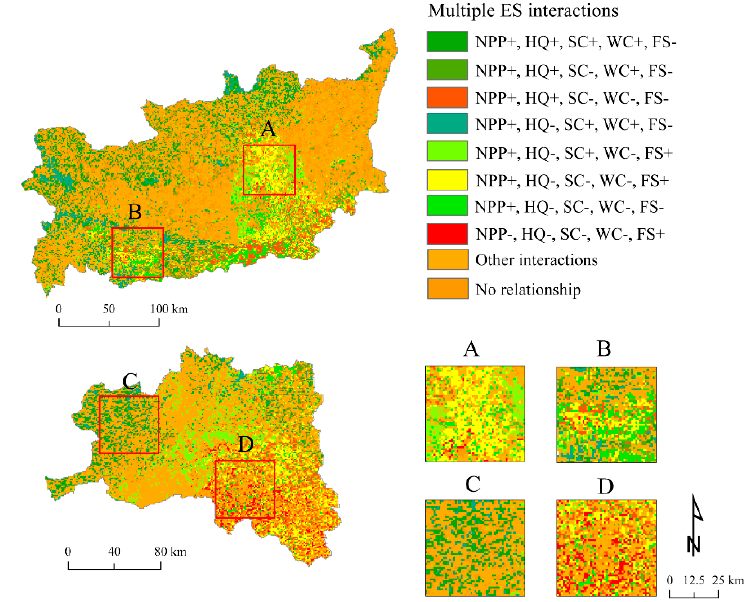
Figure 6. The spatial patterns of multiple interactions among ecosystem services(ESs) in two basins from 2000 to 2018. Because the ecosystem service assessments were based on the gird scales, the interactions among multiple ESs were complex. Some bigger area proportions and clear interactions were shown in the figure, and others are collectively named “other interactions”; ‘+’ indicated an increase of service; ‘ − ’ indicated a reduction. For example, “NPP+, HQ+, SC − , WC − , FS − ” indicates that NPP (net primary production), HQ (habitat quality) increase simultaneously (suggesting synergies), SC (soil conservation), WC (water conservation), FS (food supply) decrease simultaneously, and the two services NPP, HQ both exhibit trade-off relationships with other three services WC, SC, FS. We selected four evident trade-o ff s location ( A – D ) where the areas were 1km2, and further amplified and analyzed these